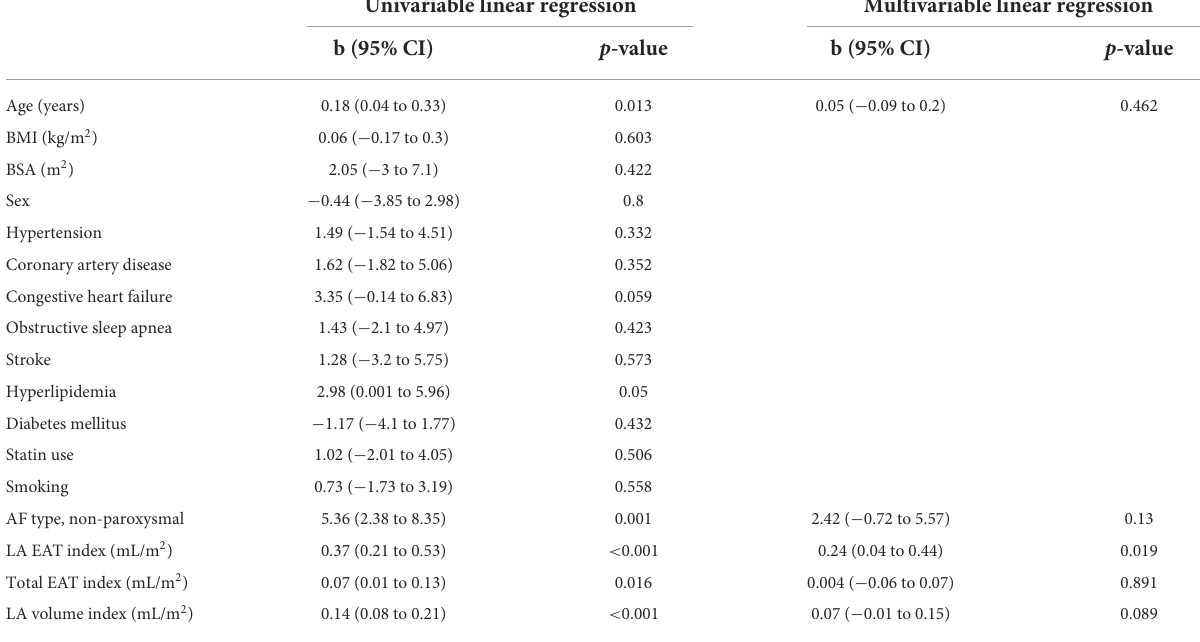
TABLE 3 Univariable and multivariable analysis for the association of LA fibrosis with baseline variables. Univariable linear regression Multivariable linear regression